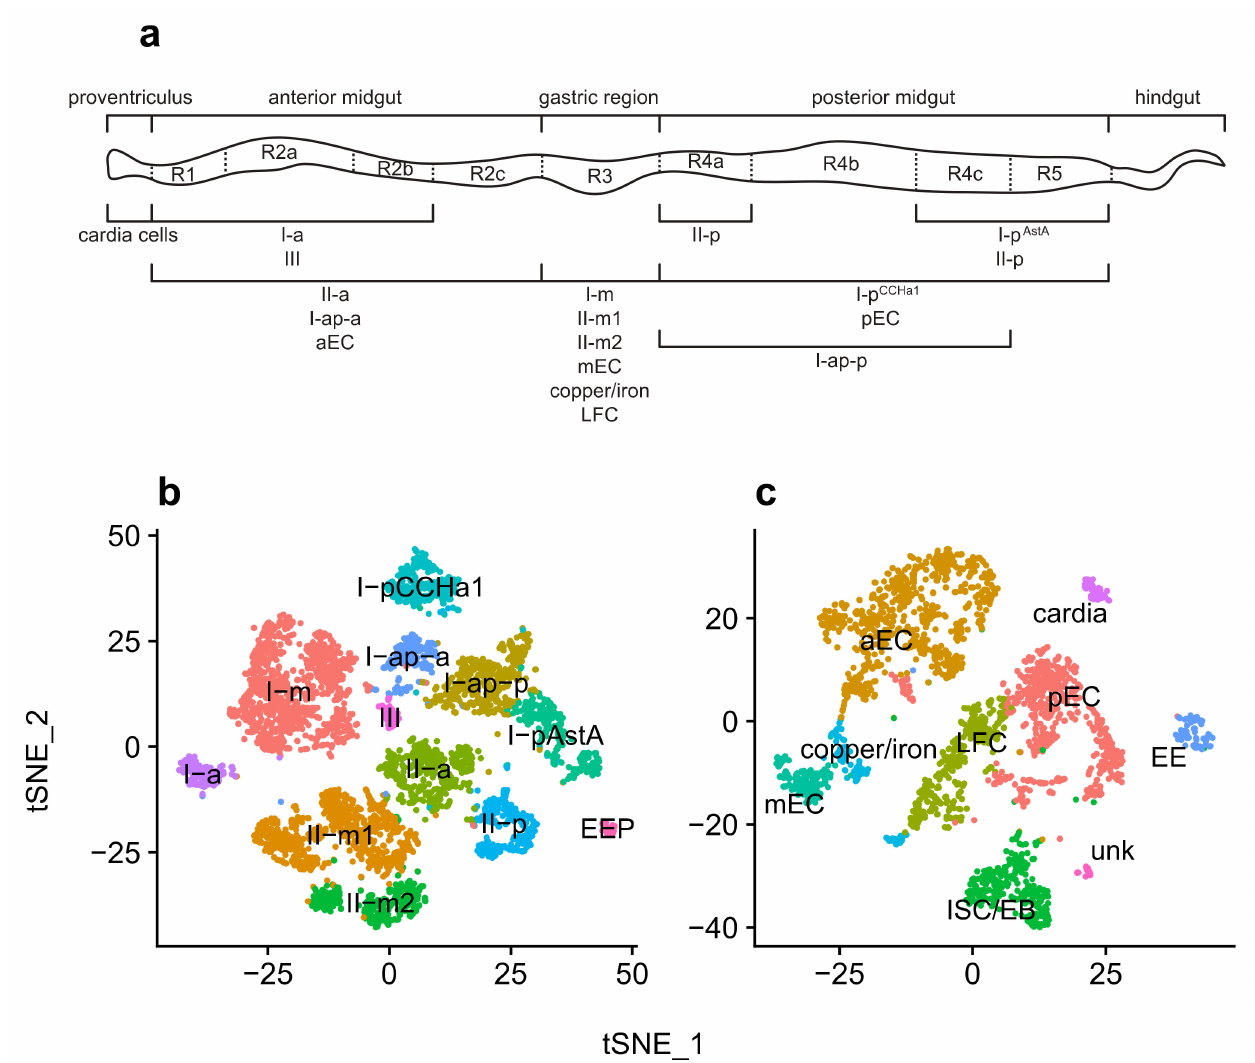
Figure 1. Spatial distribution of EE cells and of viral infections. ( a ) Schematic representation of the fly gastrointestinal tract showing the spatial distribution of EEs (adapted from [22]; published under creative commons license). ( b ) t-SNE ( t -distributed stochastic neighbor embedding) reduction plots of EEs with identified clusters. ( c ) t-SNE reduction plots of cells from the entire fly midgut with identified clusters. In both t-SNE plots, each point represents a single cell, and colors indicate labeled cell